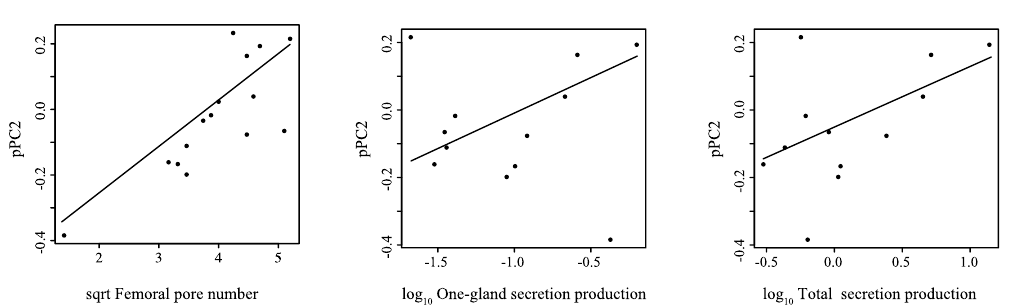
Figure 3. Graphs illustration the relationship (pGLS) between the morphology of the vomeronasal-lingual system (by PC2) of lacertid lizards and their investment in chemical signalling (as femoral pore number, one- gland secretion production and total secretion